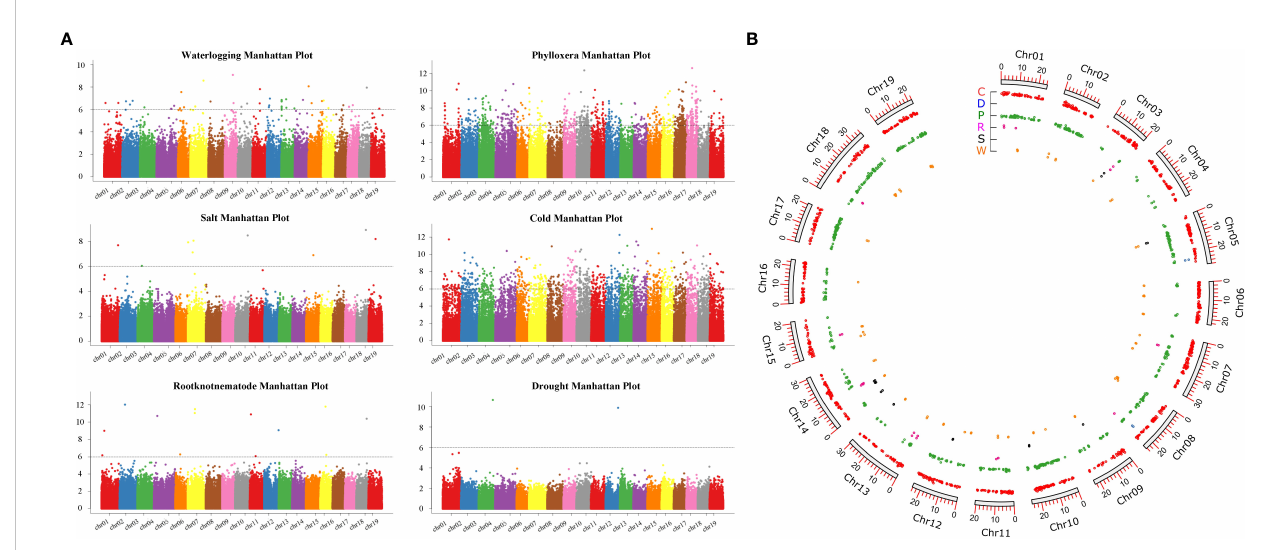
FIGURE 8 Genome-wide association analysis of six resistance traits. (A) The distribution of the P -values of the whole genome on the chromosome. The genetic marker effect value is the P -value of the whole genome after the F-test is sorted according to the physical location on the chromosome. The X -axis represents the genome coordinates, and the Y -axis represents log 10 P. The smaller the P -value, the stronger the correlation, which is expressed as a larger ordinate. (B) The distribution of the located genes on the chromosomes, P: phylloxera, R: root-knot nematode, S: salt, D, drought, C: cold, W: